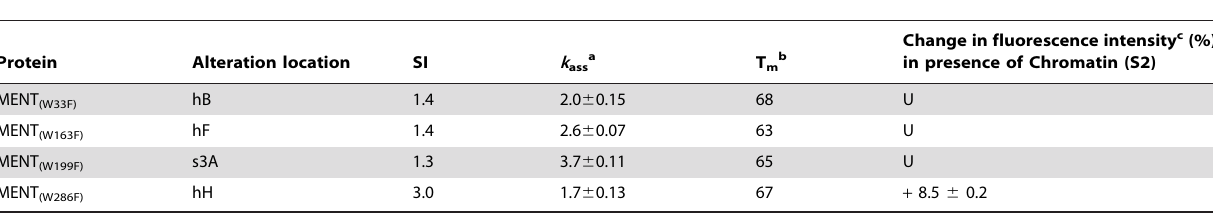
Table 2. Characterisation and fluorescence intensity of tryptophan mutant proteins.